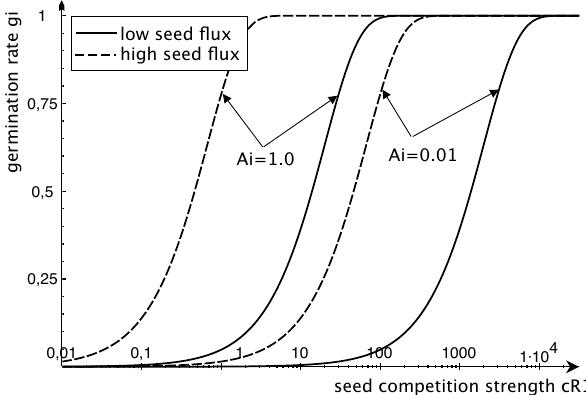
Fig. 3. Qualitative behavior of Eq. (4) with increasing seed com- petition for low and high seed flux PPS that occupy a low or high fraction of